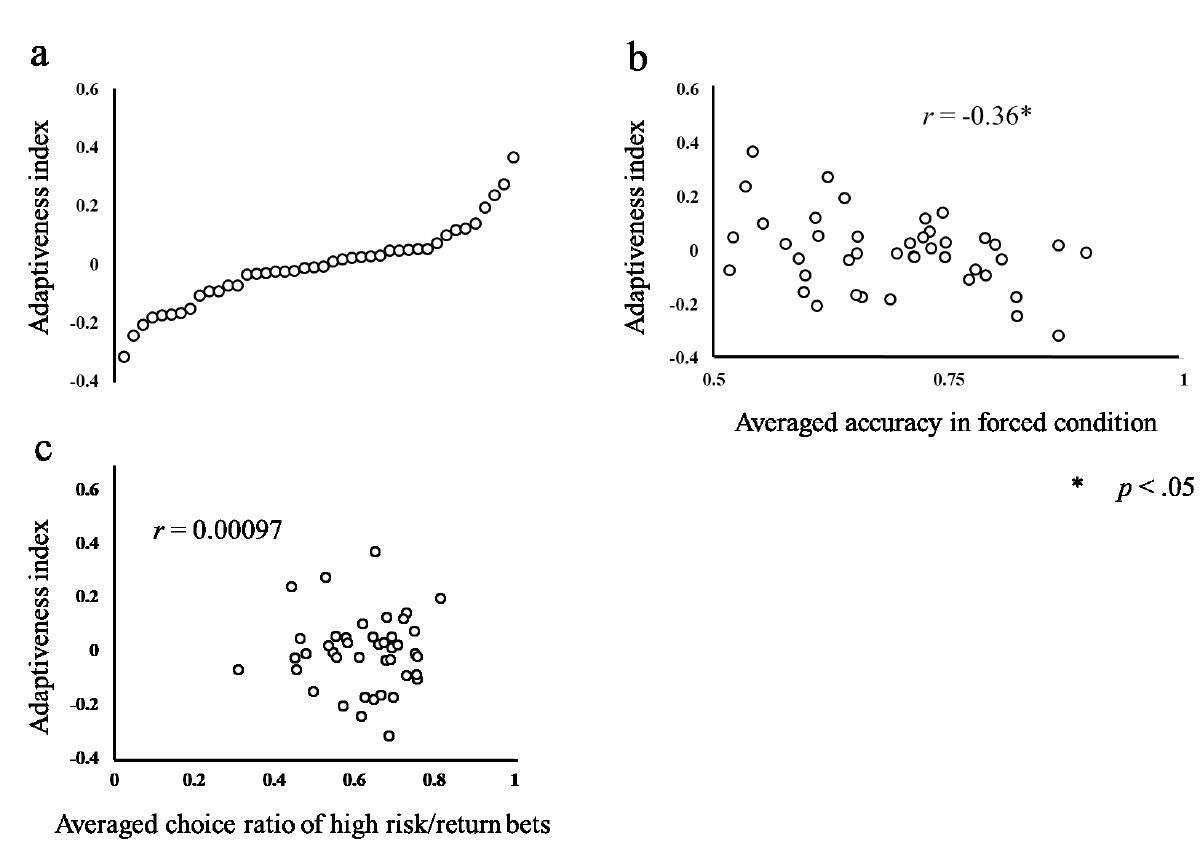
Figure 3 . (a) Plot of the adaptiveness index. Participants were sorted in ascending order in the index. Correlation between the adaptiveness index and (b) average accuracy in the forced condition or (c) average choice ratio of high-risk/return